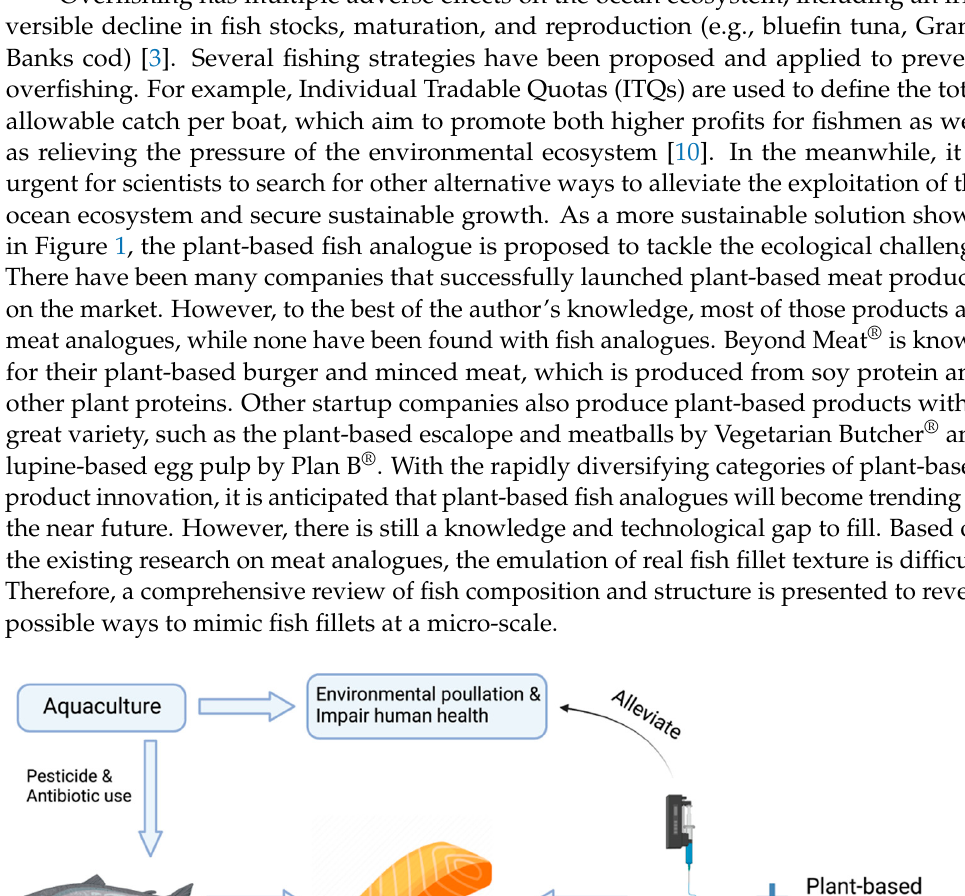
Table 1. Moisture, protein, and fat content of selected fish samples .